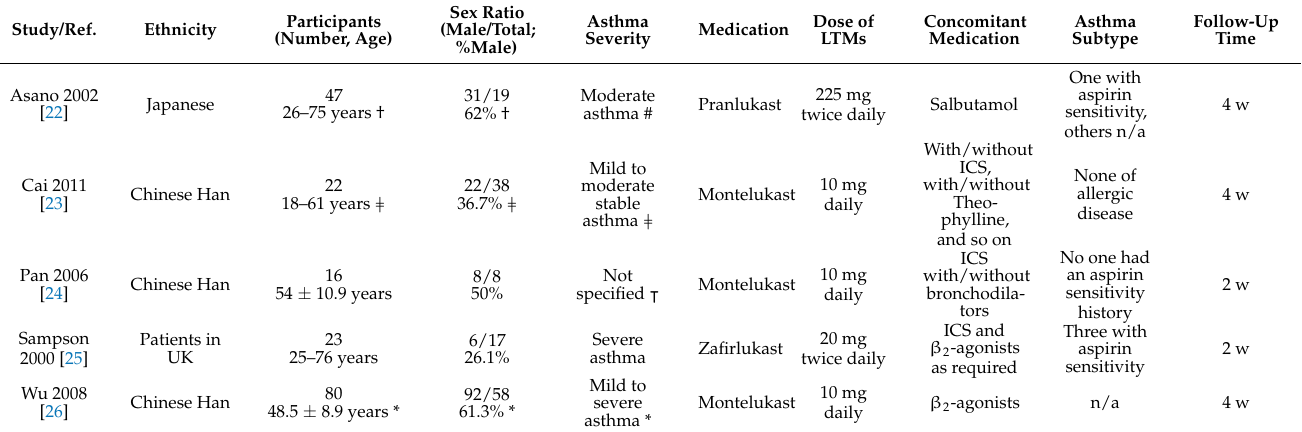
Table 3. Characteristics of studies included in LT4CS-444A/C gene meta-analysis. Study/Ref.